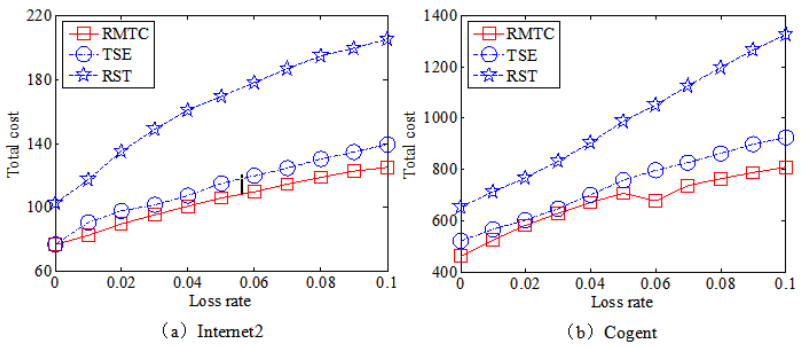
Figure 10. Impact of loss rate β in ( a ) Internet2; ( b )